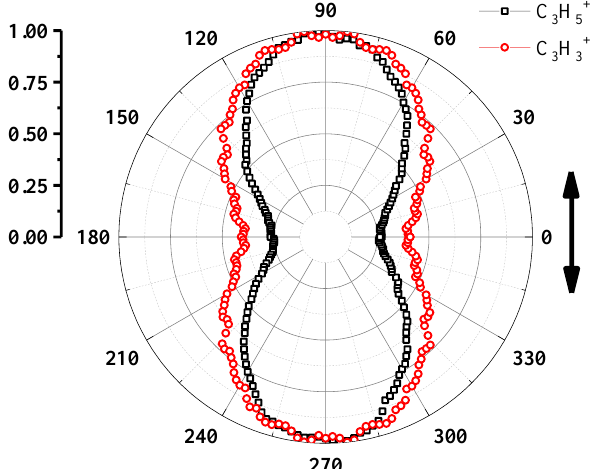
Figure 6. The angular distributions of C 3 H 5+ and C 3 H 3+ ions and the double arrow represents the direction of laser polarization.